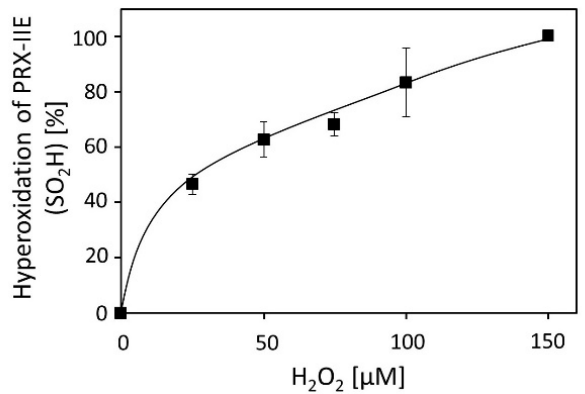
Figure 4. H 2 O 2 -dependent hyperoxidation of PRX-IIE. Pre-reduced and desalted PRX-IIE at 10 µM concentration was incubated with H 2 O 2 as indicated in the presence of 500 µM DTT for 15 min. This allowed for continued re-reduction and H 2 O 2 -dependent oxidation and accumulation of the hyperoxidized form. The extent of sulfinic acid formation in percent of the total was estimated from the ratio of the peak intensities for the reduced (SH; 19.438 Da) and hyperoxidized (SO 2 H; 19.470 Da) protein in the deconvoluted ESI-MS spectra. Data are means of n = 10 ± SD with recom- binant protein from two independent purifications.